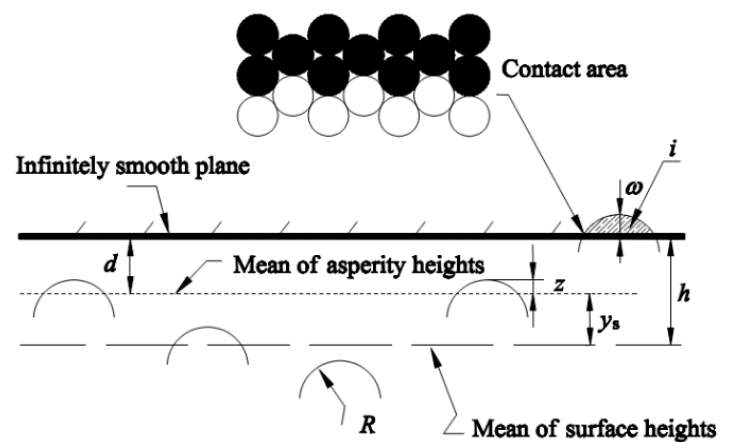
Figure 1. Contact model of nominally flat rough surfaces [23].